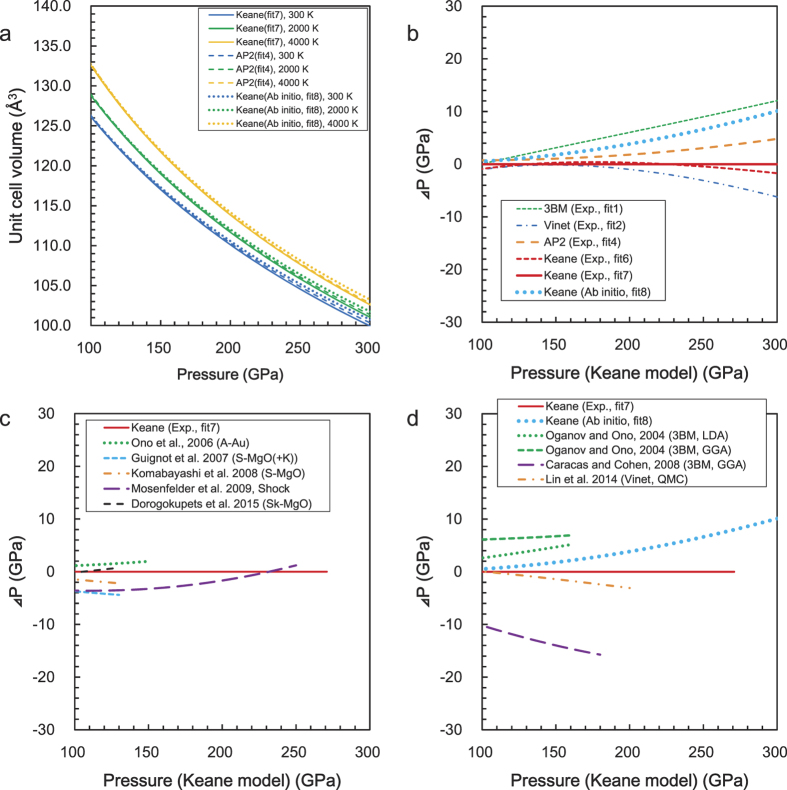
(a) The compression curves for the experimental Keane and AP2 EoS and theoretical Keane EoS. (b) The pressure differences for the 3BM (fit 1), Vinet (fit 2), AP2 (fit 4) and Keane (fits 6 and 8) with respect to the Keane EoS (fit 7) at 300 K. (c) The comparison between fit 7 and the previous experimental works at 300 K. A-Au, Anderson et al.’s Au scale29; S-MgO, Speziale et al.’s MgO scale21; K, Karki et al.’s MgO scale30; Sk-MgO, Sokolova et al.’s MgO scale22, respectively. (d) The comparison between fit 7 and the previous theoretical works at 300 K.